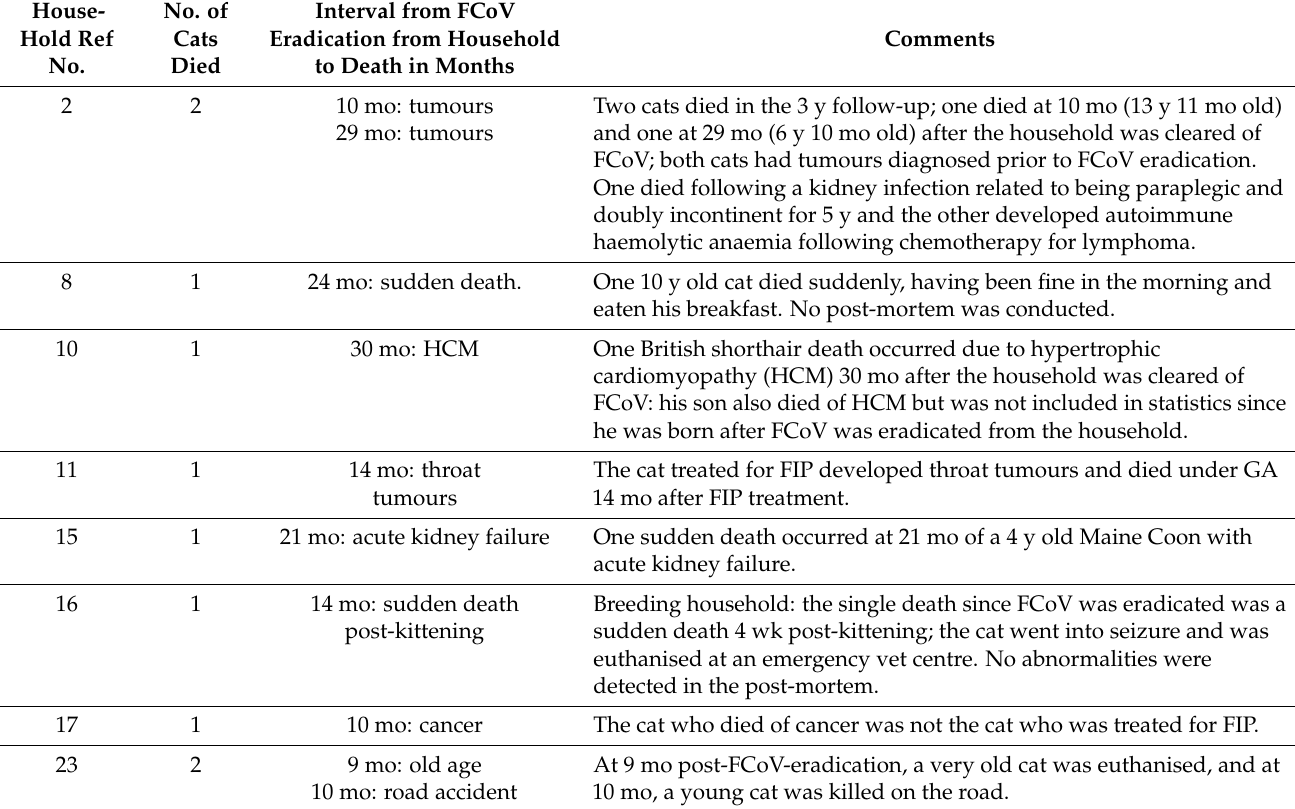
Table 2. Causes of death in 11 cats who died after FCoV eradication from their